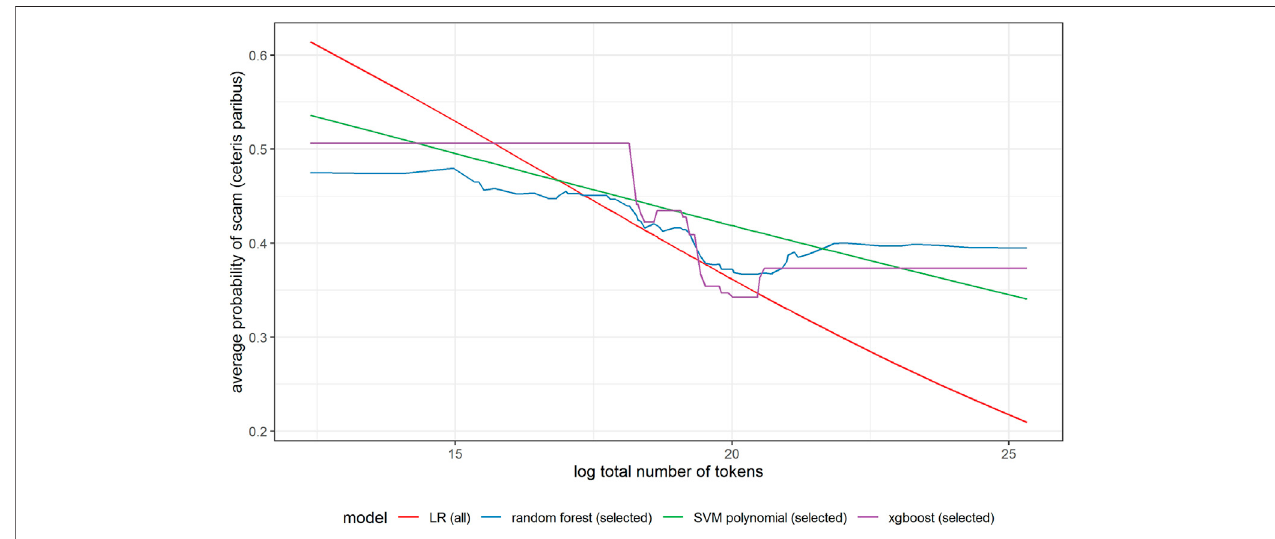
FIGURE 8 | Partial dependence plot for variable indicating total number of tokens (log).